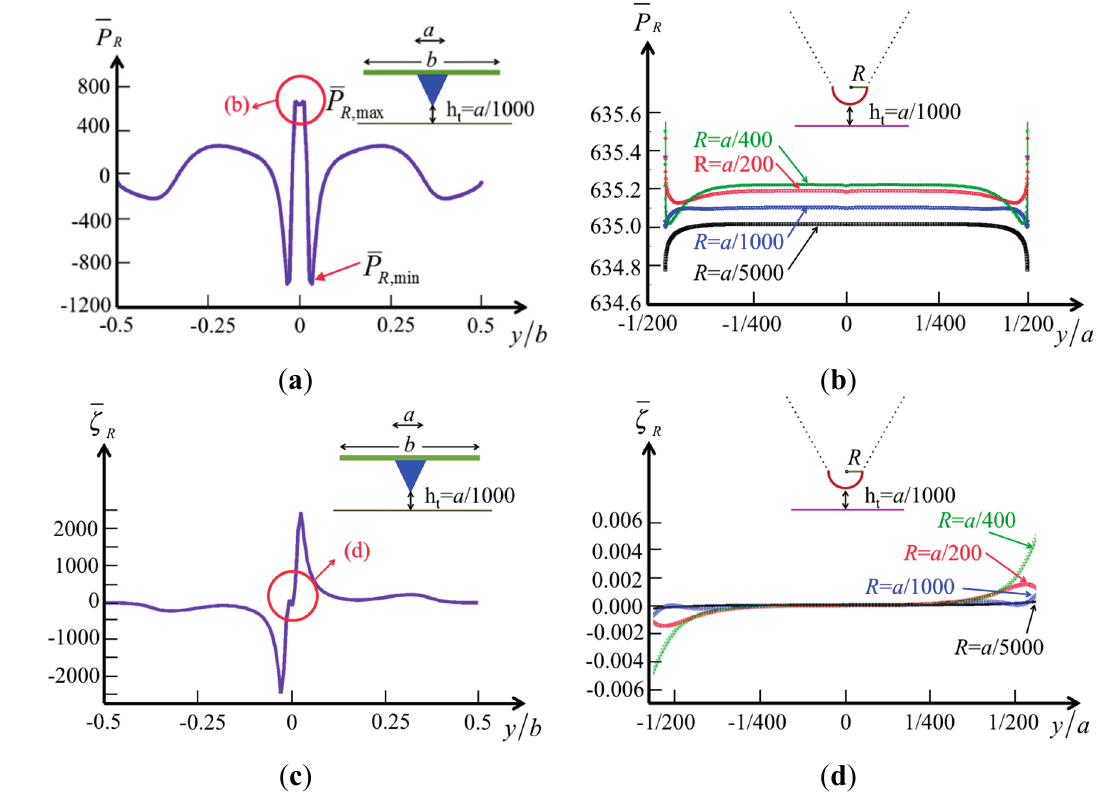
Figure 7. The normalized pressure and vorticity in real part over the surface of the specimen by a cone tip at a constant tip height h t / a = 0.001 ( a ) pressure in global region; ( b ) pressure in local region with various tip radii; ( c ) vorticity in global region; and ( d ) vorticity in local region with various tip radii.